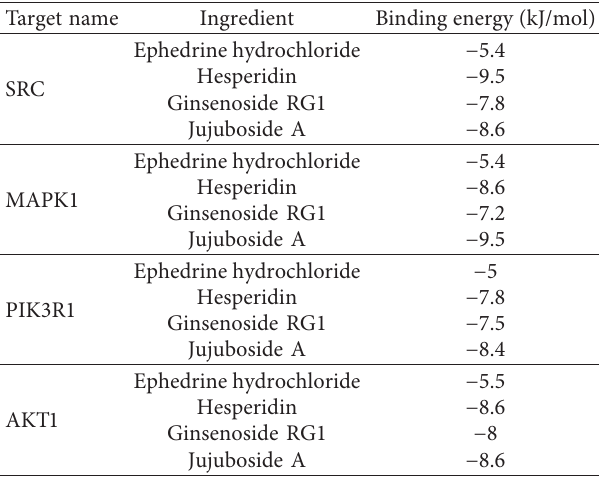
Table 1: Molecular docking results of some components with